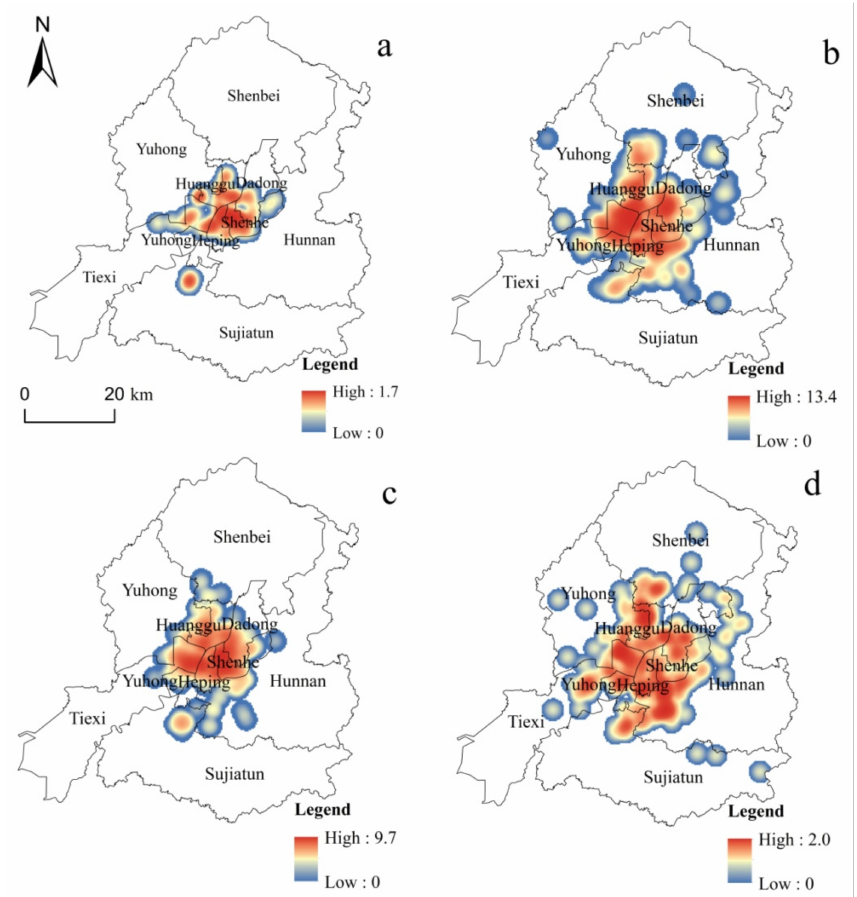
Figure 3. New communities distribution in different stages. ( a ) Slow development stage. ( b ) Rapid expansion stage. ( c ) High-speed development stage. ( d ) Stable extension